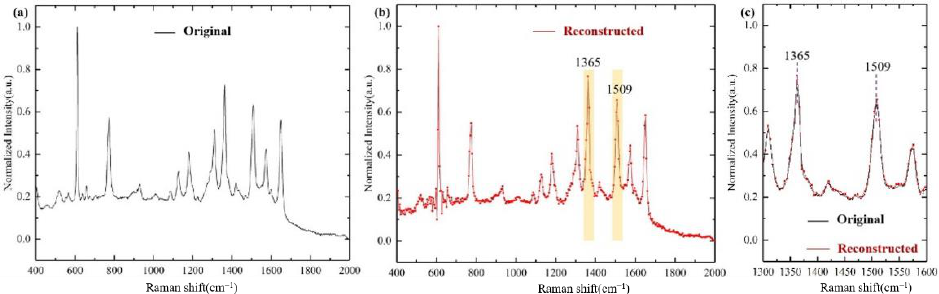
Figure 6. ( a ) Original Raman intensity information; ( b ) Reconstructed Raman information; ( c ) Typ- ical characteristic peaks near 1365cm −1 and 1509cm −1 restored spectrum (red) and original spec- trum (black).